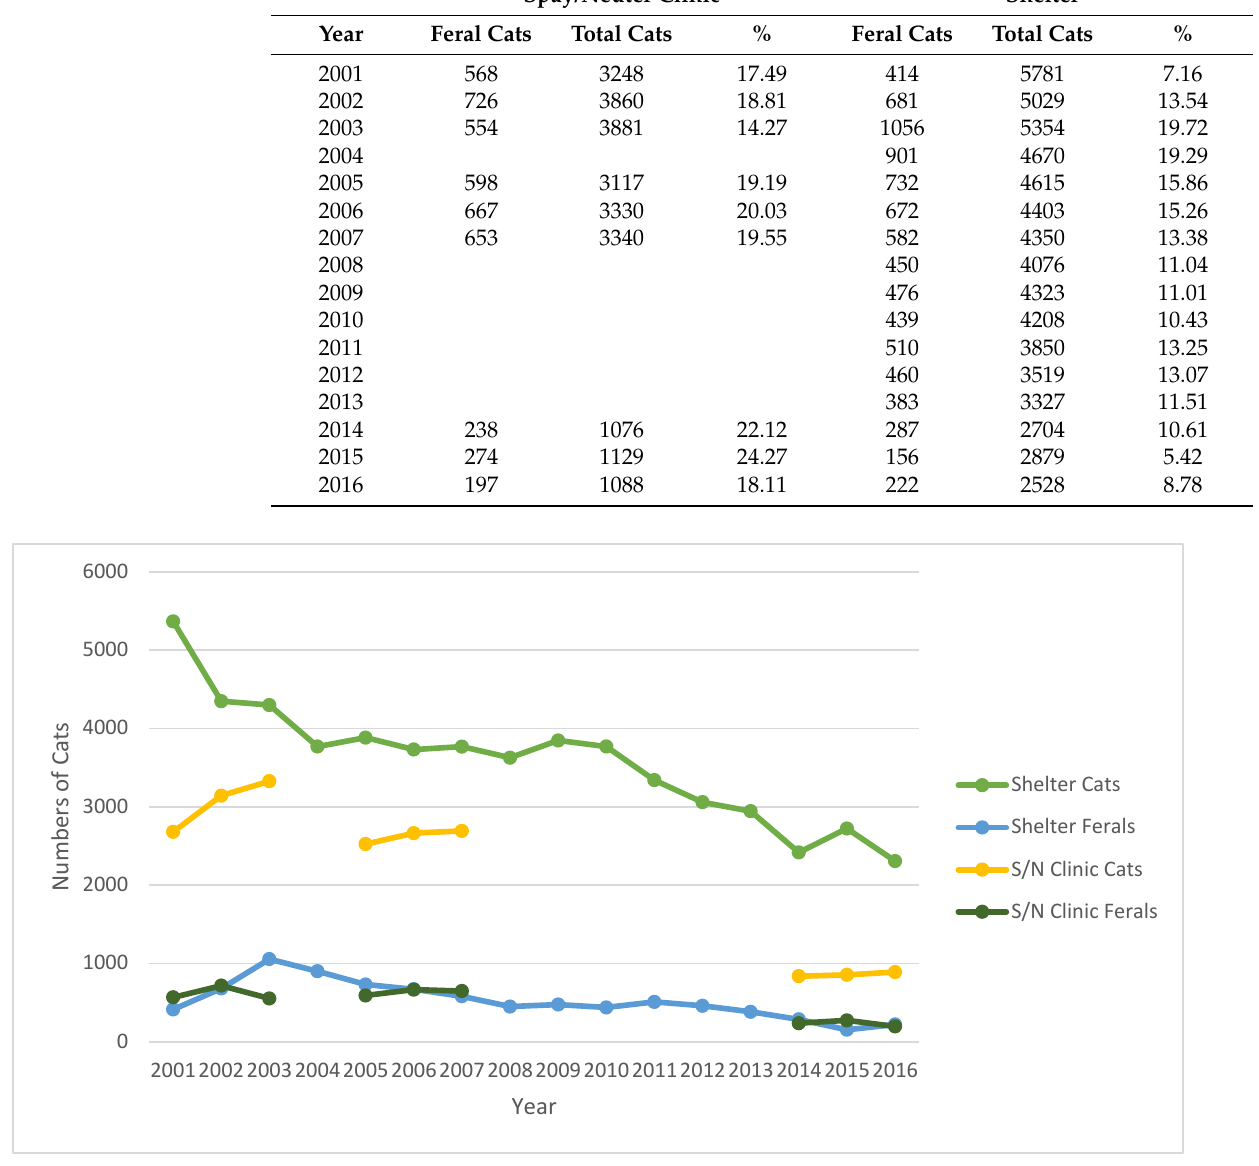
Figure 1. Numbers of cats presented to the PHS Shelter and Spay/Neuter Clinic, 2001–2016. Between 2001 to 2003, retroviral status was complete for all cats. For those with retroviral data, 32 (1.73%) and 102 (5.52%) feral cats tested positive for FeLV and FIV, respectively (Table 2). The prevalence of FeLV or FIV did not vary significantly across this period ( p = 0.09 and 0.84, respectively). As 76 of 1848 (4.11%) feral cats had missing information for sex, further analysis was completed for 1772 cats (814 males, 958 females) (Table 3, Figures 2–4). Twenty-eight of 1772 (1.58%) cats tested positive for FeLV; 85 (4.80%) tested positive for FIV. FeLV prevalence was not significantly different between male and female cats, while FIV prevalence between males and females differed significantly each year and across the period ( p < 0.01 each year and across the period). Four cats, all males, tested positive for both retroviruses. Overall, 22 males, 31 females, and one cat of unknown sex had already been altered, and three cats had tattoos indicating prior spay